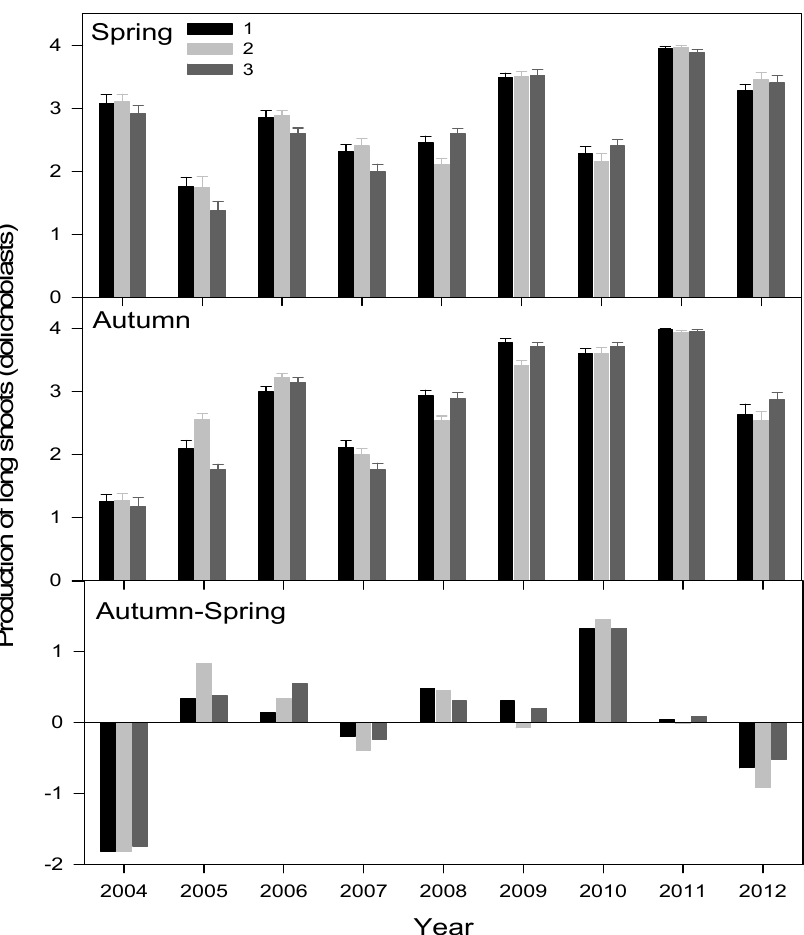
Figure 3. Estimated production of long shoots or dolichoblasts (means ± SE) in spring and autumn in the three holm oak study stands from 2004 to 2012. The lowermost plot shows the difference between mean shoot production in autumn and